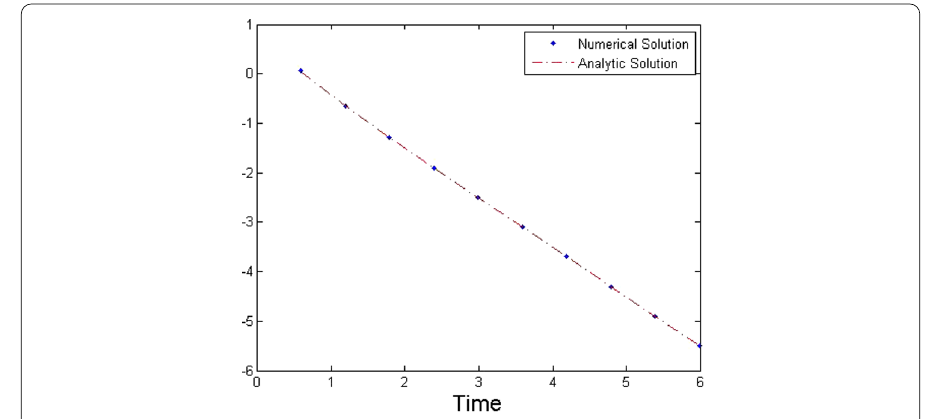
Figure 4 Comparison of numerical solution given by the ECI algorithm and analytic